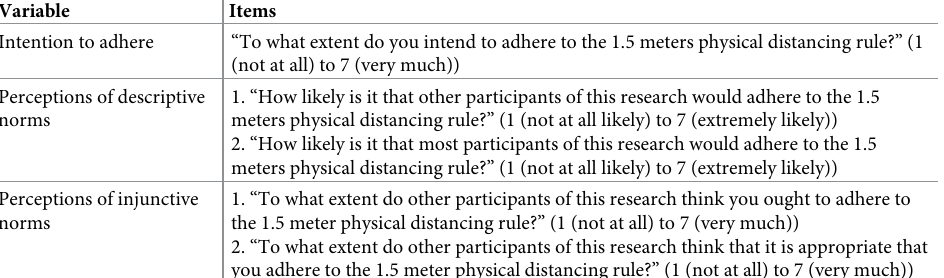
Table 2. Items assessing intention, perceptions of descriptive norms, and injunctive